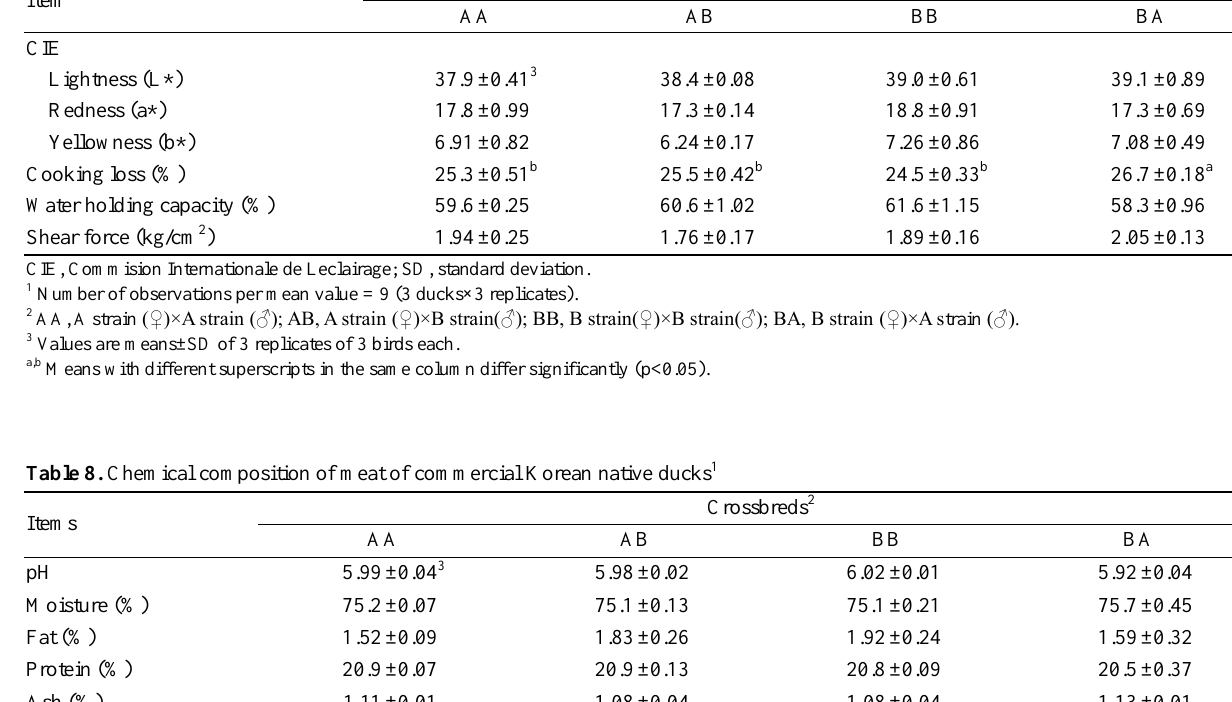
Table 7. Breast meat color and quality characteristics of commercial Korean native ducks 1